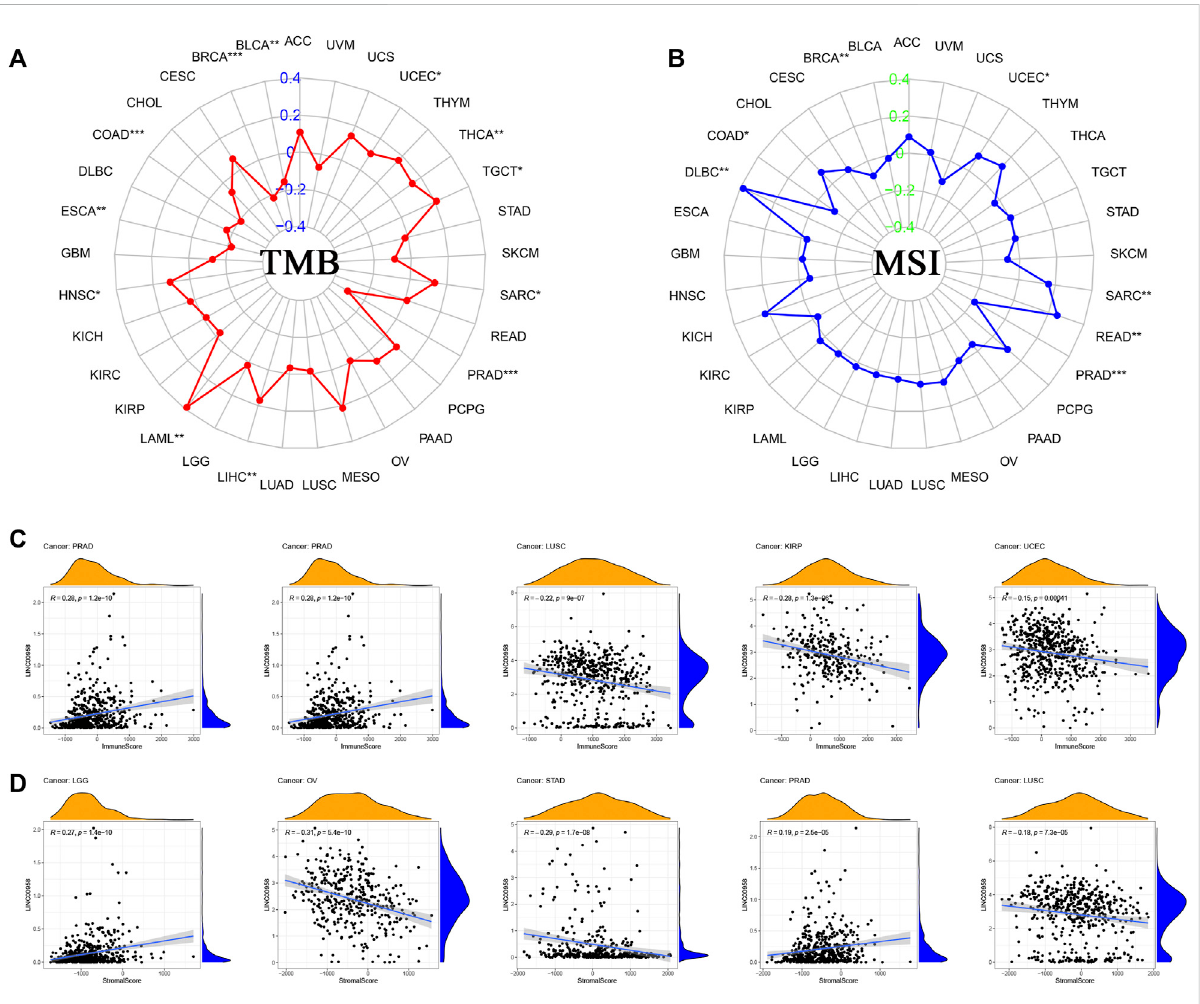
FIGURE 8 Correlations between LINC00958 expression and immunity, including TMB, MSI, stromal score, and immune score in cancers. (A) The radar chart showed the correlation between TMB and LINC00958 expression in pan-cancer. The red curve indicates the correlation coef fi cient, and the blue value indicates the range. (B) The radar chart showed the correlation between MSI and LINC00958 expression in pan-cancer. The blue curve indicates the correlation coef fi cient, and the green value indicates the range. * p < 0.05, ** p < 0.01, and *** p < 0.001. (C) Correlation of LINC00958 expression with the immune score in pan-cancer. (D) Correlation of LINC00958 expression with the stromal score in